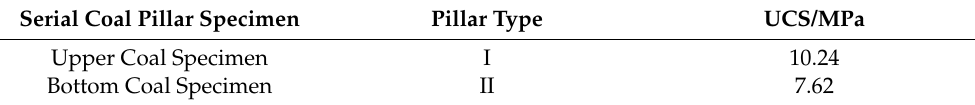
Table 2. Parameters of serial coal pillar specimens with different